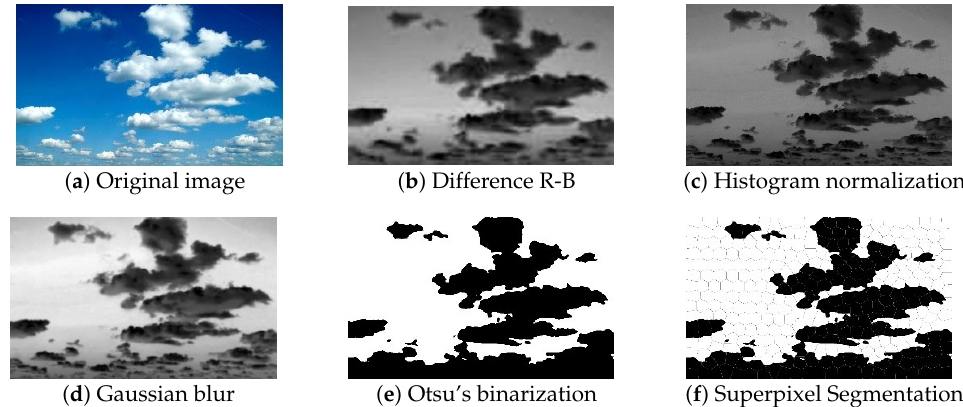
Figure 3. Steps to generate the proposed descriptor for three classes (ground, cloud and sky).